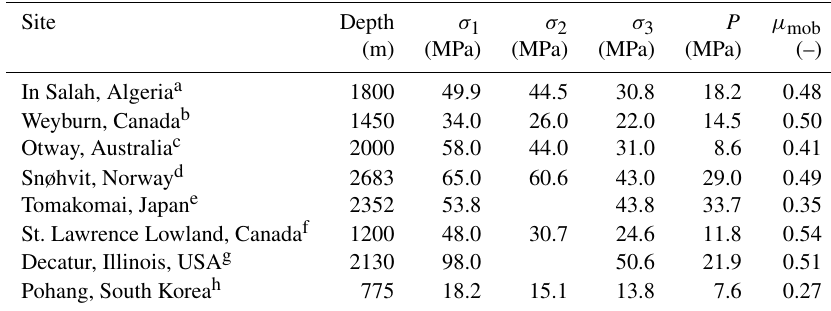
Table 1. Stress state (maximum principal stress, σ 1 ; intermediate principal stress, σ 2 ; minimum principal stress, σ 3 ; and pore pressure, P ) and mobilized friction coefficient ( µ mob ) at several CO 2 injection sites.